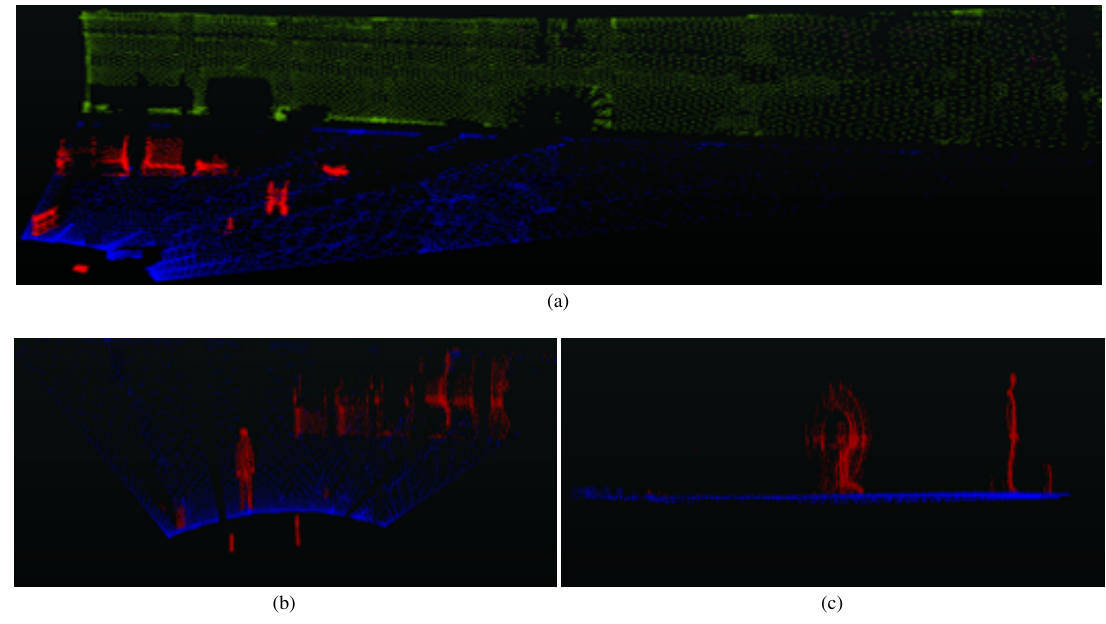
Figure 9. (a), (b) and (c) show the classification results. In blue are the 3D points classified as “Ground”, in green are the 3D points classified as “Building” and in red are the 3D points classified as